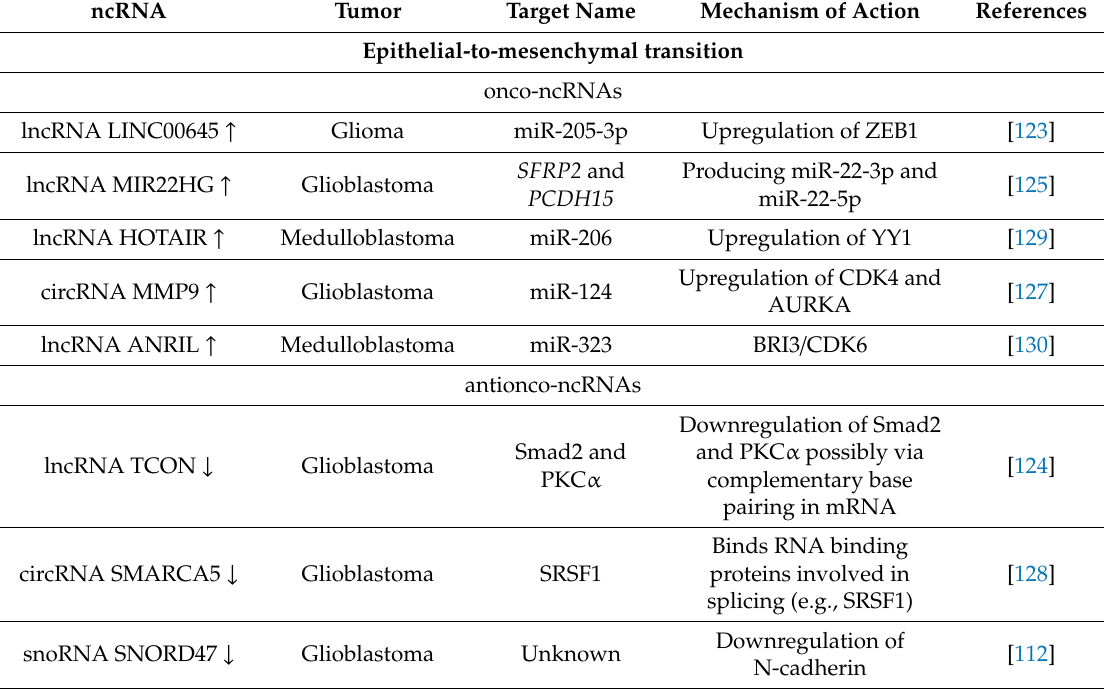
Table 3. Oncogenic or tumor-suppressive lncRNAs, circRNAs, and snoRNAs involved in the regulation of the epithelial-to-mesenchymal transition